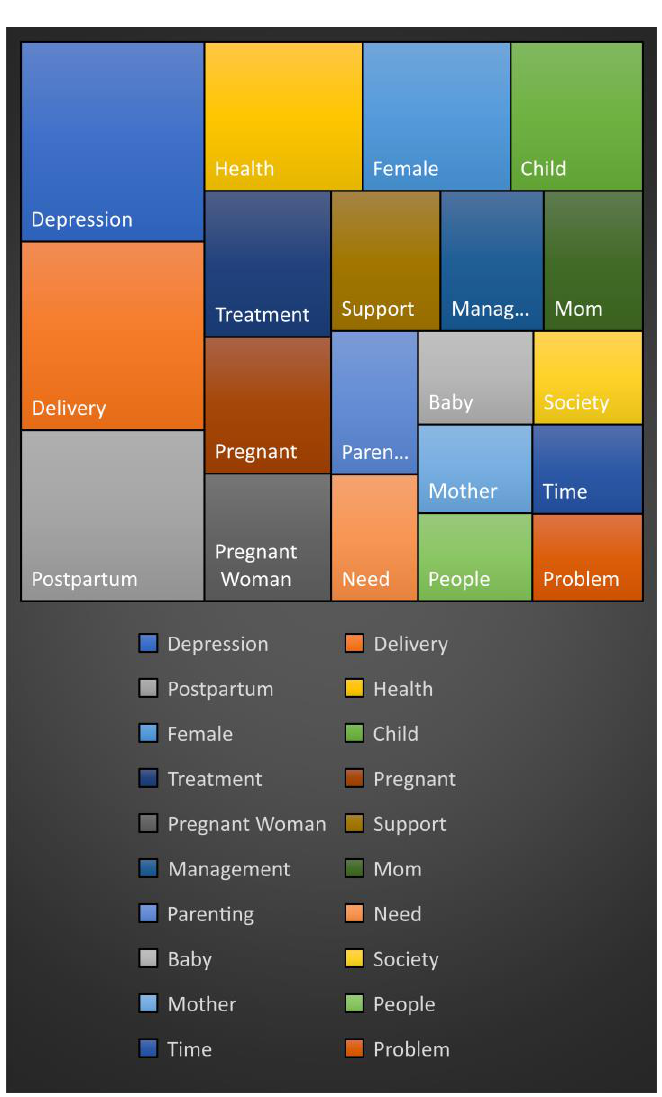
Figure 2. Frequency of keywords using the simple frequency analysis.